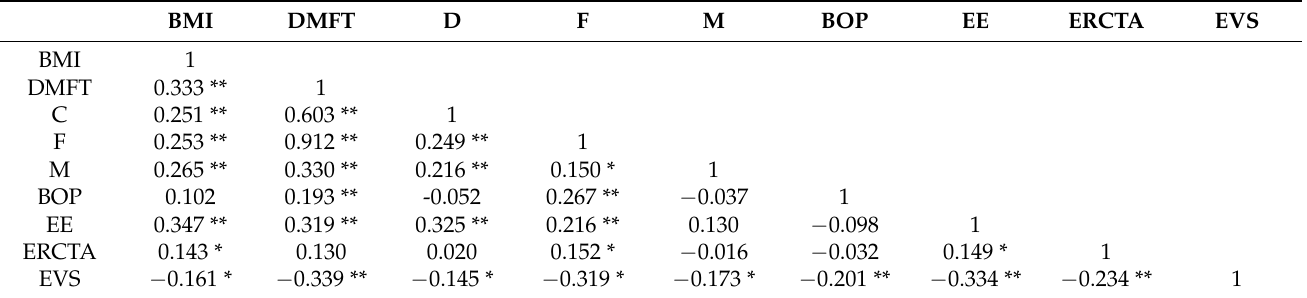
Table 1. Associations among variables of oral health, eating habits, type A personality and lifestyle.